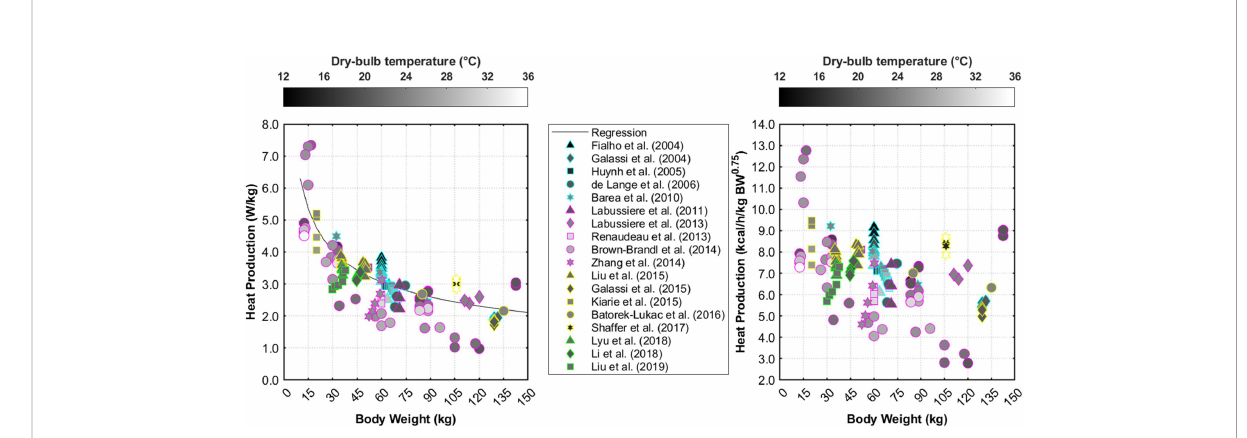
FIGURE 2 All growing pig total heat production as a function of reported or mean body weight identi fi ed by reference (marker shape and outline color) and reported study temperature (marker